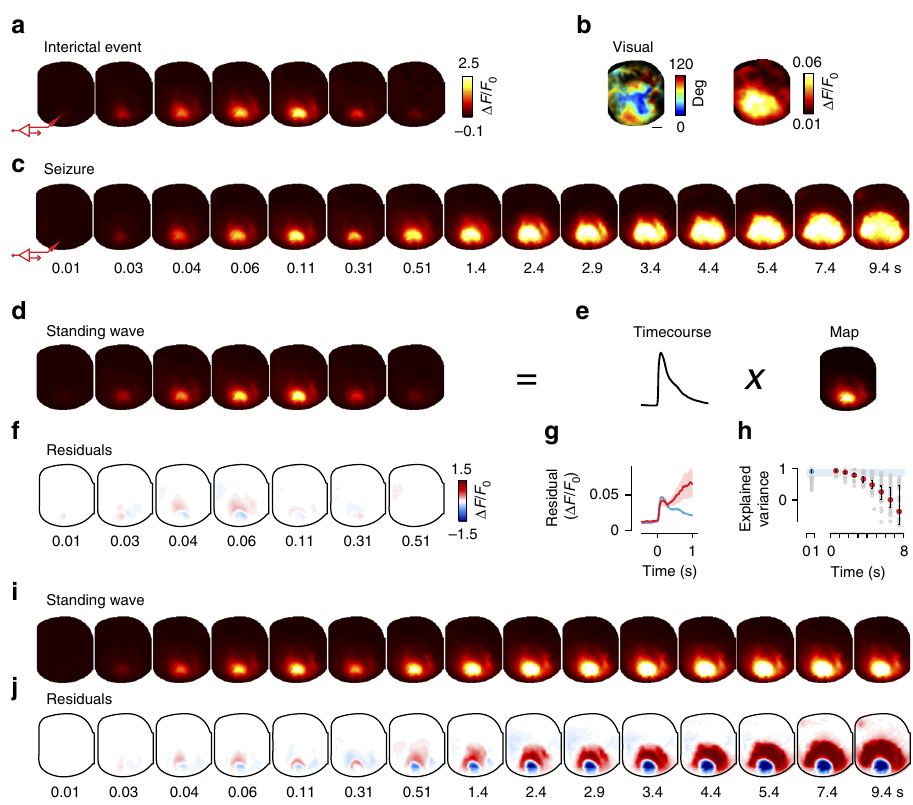
Fig. 3 Interictal events and seizures start as standing waves, and seizures subsequently propagate widely across cortex. a Frames obtained through GCaMP imaging in a representative interictal event (the one with LFP in Fig. 2h and j). The cartoon electrode indicates the site of Ptx injection and epileptic focus. b Retinotopic map and map of maximal activation in response to visual stimulation for this animal. Scale bar is 1 mm. c Same as a , for a representative seizure (the one highlighted in Fig. 2i and k). Labels indicate the time of each frame from event onset and apply to frames in a and c . d Predictions of a standing wave model fi t to interictal event in a . e The standing wave is the product of a single temporal waveform (Time course) and a fi xed spatial pro fi le (Map). The map and the time course shown are averaged across interictal events for this animal. f The residuals of the fi t in e are small, indicating little deviation of interictal event from standing wave. g The root-mean-square residuals for the standing wave model applied to interictal events ( blue ) and seizures ( red ). The spatial map was optimized to fi t interictal events. Shaded areas indicate two s.e.m. h Variance explained by the standing wave model for interictal events ( blue dot ) and 1 s intervals of seizures ( red dots ). Error bars show median ± 1 quartile. Shaded blue area indicates the 96% con fi dence interval for quality of the fi t to interictal events. i Predictions of the standing wave model for the seizure in c . The model was constrained to have the same spatial map as interictal events, and was free to have the best- fi tting time course. j Residuals between seizure and standing wave model are small in the fi rst ~0.3 s after onset, but subsequently become prominent, when the standing wave model fails to capture the propagation typical of